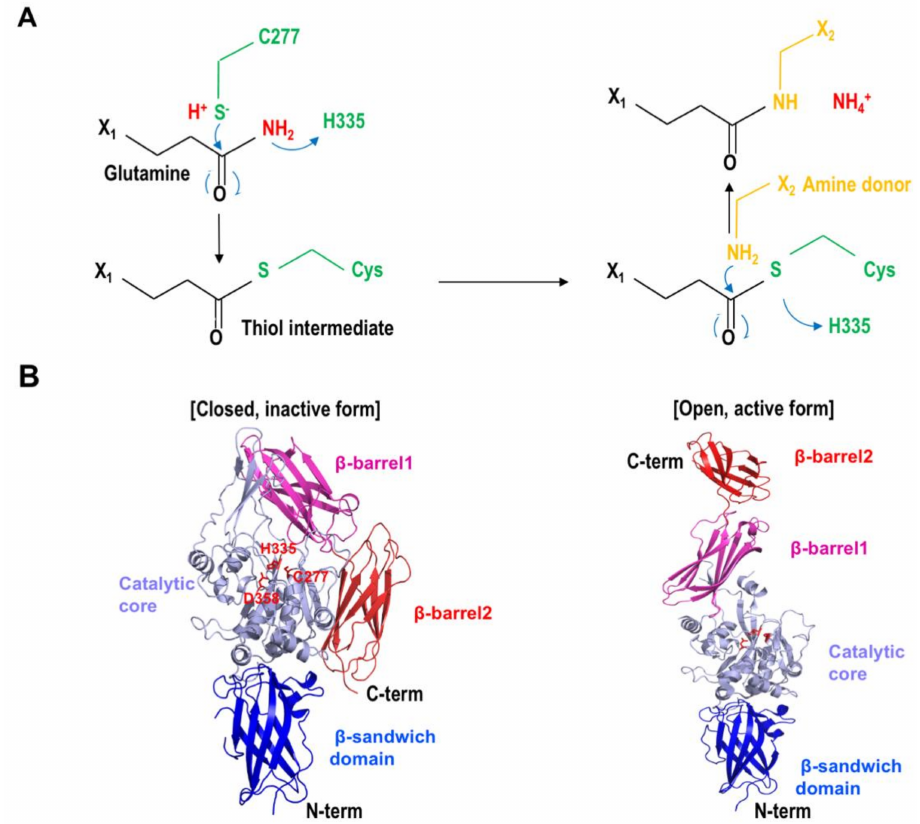
Figure 1. Reaction mechanism of transglutaminase 2 (TGase2). ( A ) Transamidation reaction mechanism of TGase2. Residues in green are from TGase2. Two consecutive nucleophilic attacks by the thiol group from the active site on TGase2 and the amine donor are shown. ( B ) Figures of the closed inactive form and the open active form of TGase2 showing the catalytic triad composed of C277, H335, and D358. The four distinct domains, β -sandwich domain, catalytic core domain, β -barrel1, and β -barrel2, are visually distinguished by the di ff erent